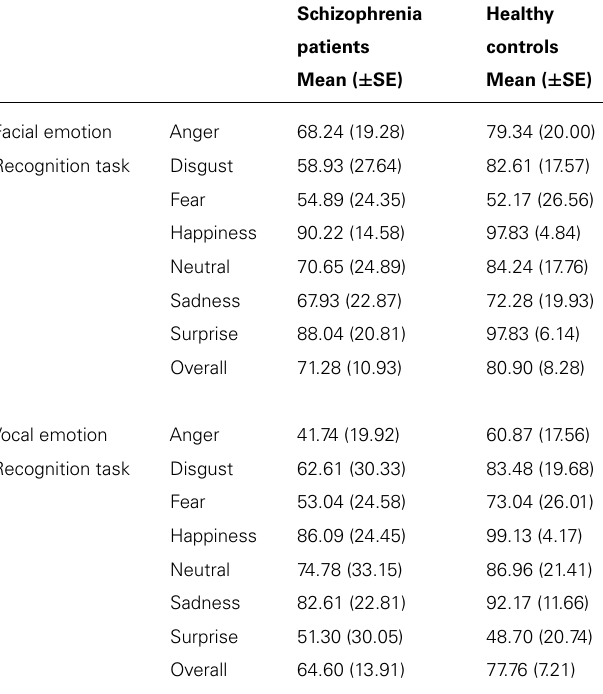
Table 3 | Number of correct responses, expressed as a percentage of total responses (standard errors, SE) for categorical judgments in the facial and vocal emotion recognition tasks of patients with schizophrenia and healthy controls.